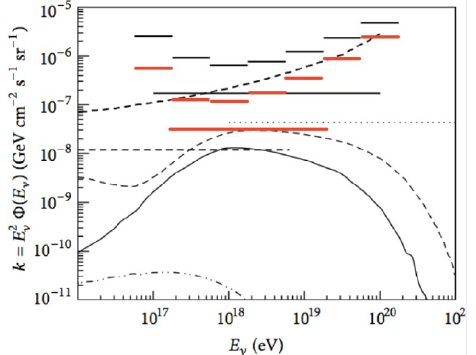
Figure 5: Differential and integrated upper limits on the single flavour E − 2 ν flux (thin black lines: downward-going ν , thick red line: Earth-skimming ν ). Different models are shown for comparison and dis- cussed in [23]